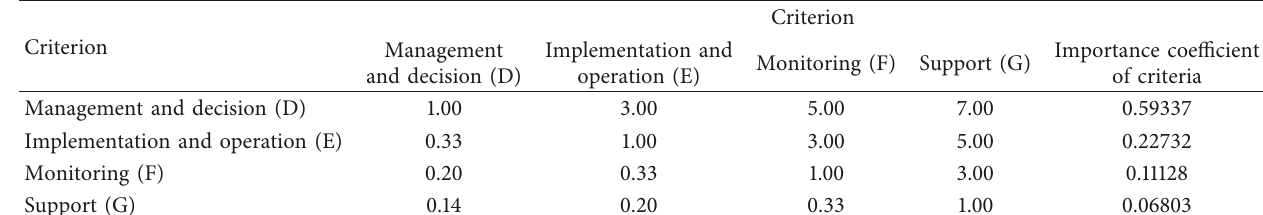
Table 9: Binary matrix and local priority coefficient of